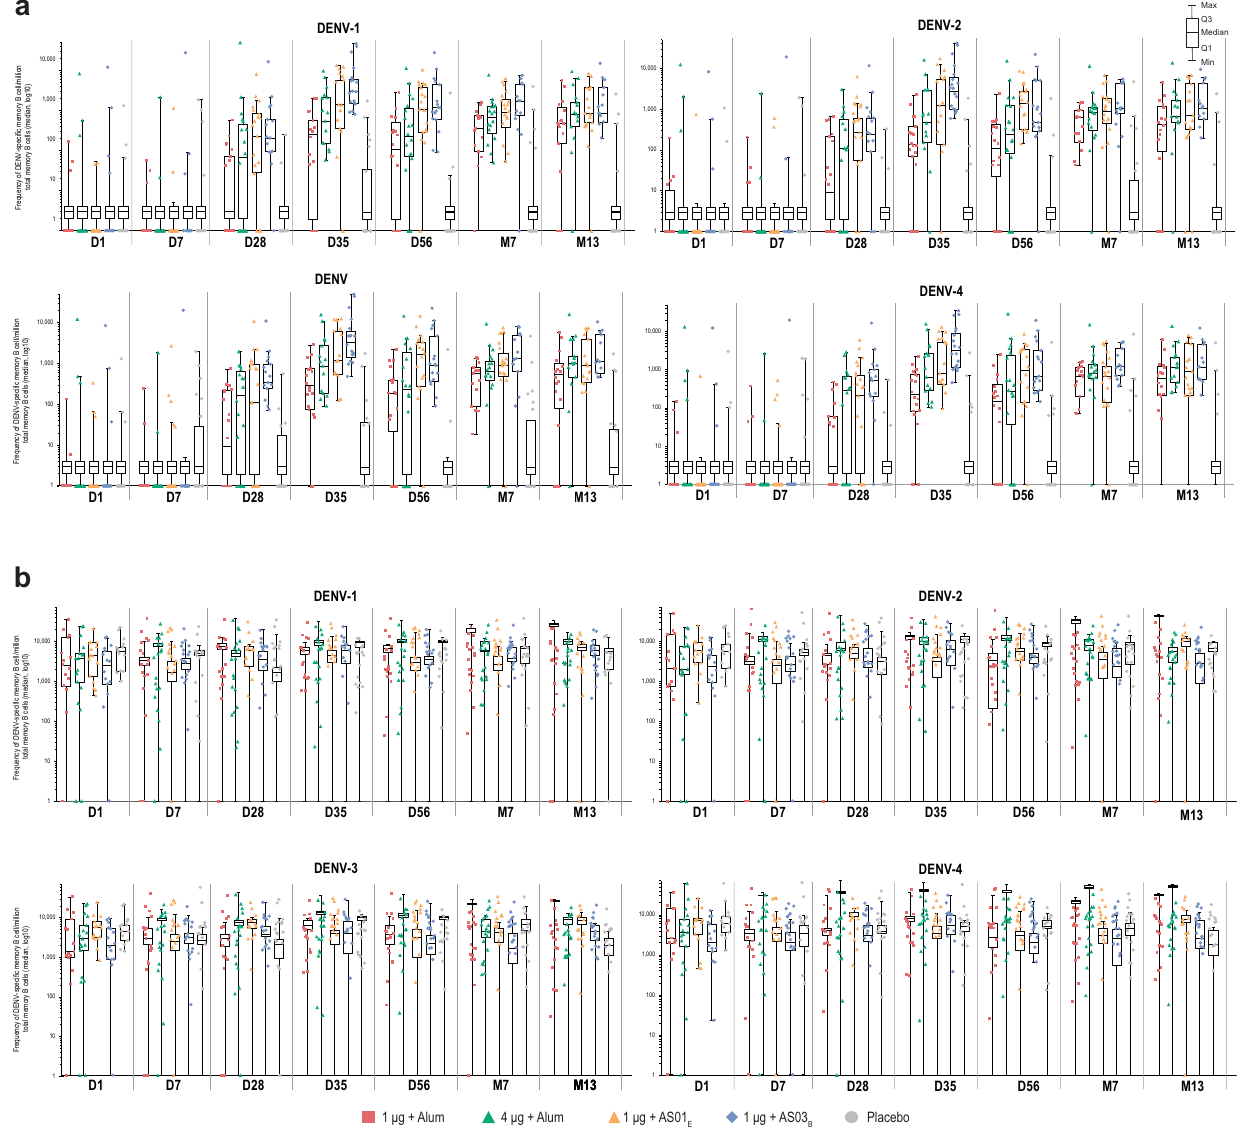
Fig. 1 Frequencies of memory B cells speci fi c to dengue virus serotypes 1 – 4. Values are shown at multiple time points in dengue-naive ( a ) and dengue-primed ( b ) adults following 2-dose DPIV vaccination (adapted according-to-protocol cohort for immunogenicity). Error bars on the box plot represent the Min and Max values in each group. Min and Max values were calculated as (Q1 – 1.5*interquartile range)/(Q3 + 1.5* interquartile range). Individual values are plotted for each group. D, day; D0, pre-vaccination; D7, 7 days post-dose 1; D28, 28 days post-dose 1; D35, 7 days post-dose 2; D56, 28 days post-dose 2; DENV, dengue virus; DPIV, tetravalent dengue puri fi ed inactivated vaccine; M, month; M7, 6 months post-dose 2; M13, 12 months post-dose